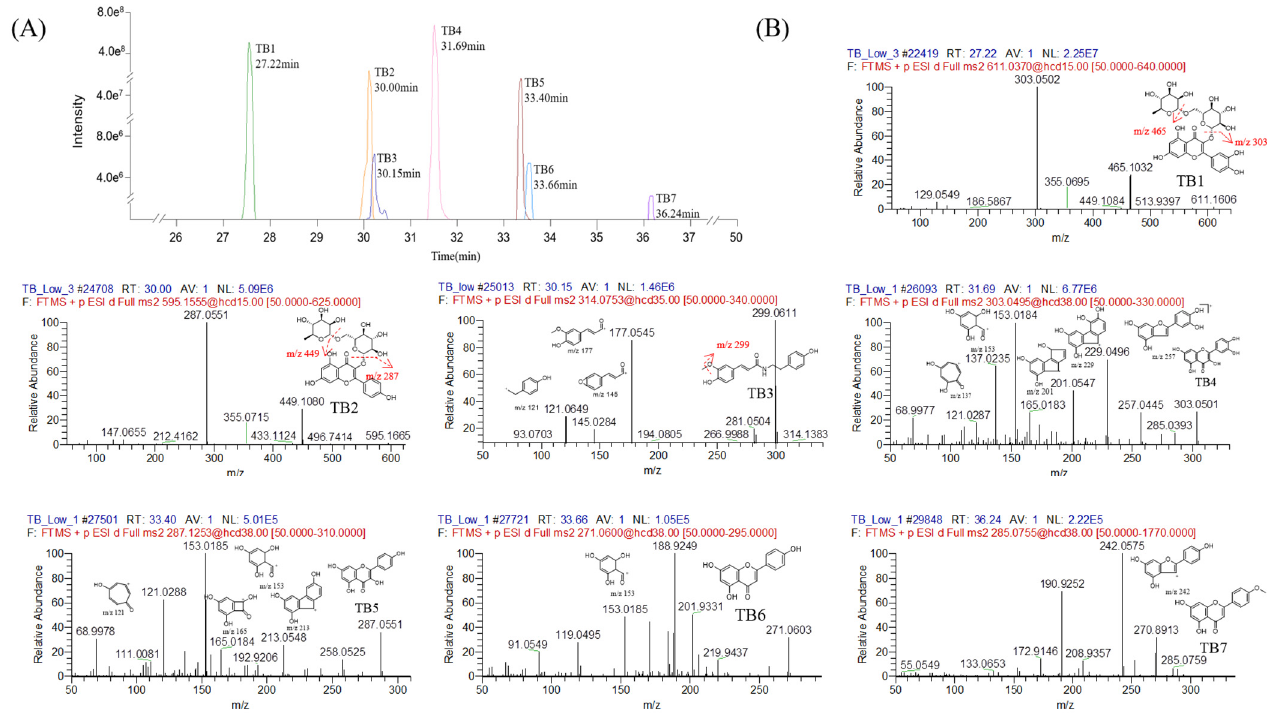
Figure 2. The typical chromatogram ( A ) and MS/MS (MS 2 ) spectra ( B ) of chemical components (TB1-